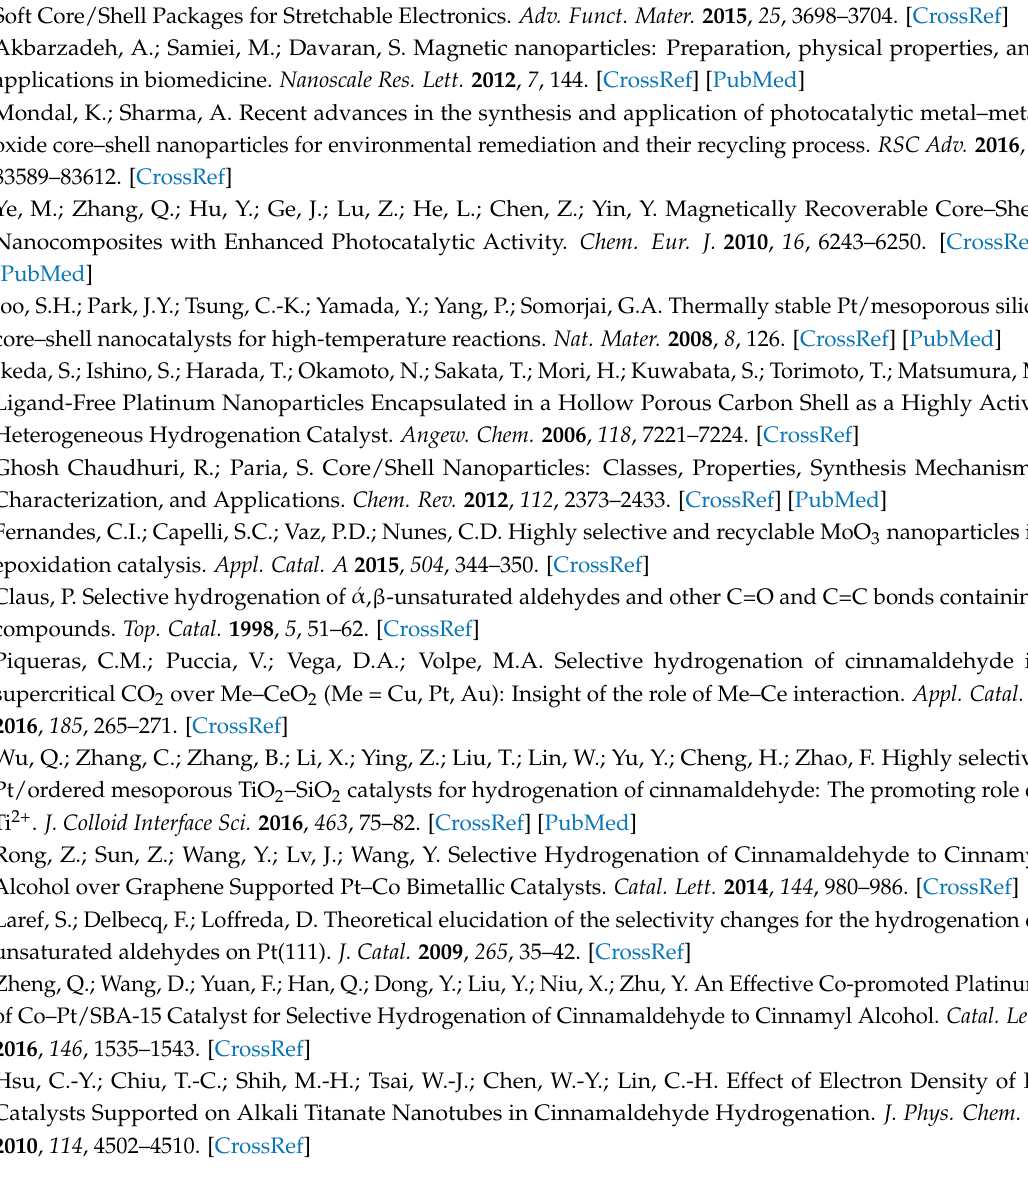
Figure S1: Micrograph of Fe 3 O 4 nanoparticles, Figure S2: Micrograph of Fe 3 O 4 –SiO 2 core-shell material, Figure S3: Micrograph of Fe 2 O 3 –SiO 2 –TiO 2 –5%Pt one-step core-shell material, Figure S4: N 2 adsorption desorption Isotherm, Figure S5: XRD pattern for Fe 3 O 4 and γ -Fe 2 O 3 nanoparticles, Figure S6: TPR-1 and TPR-2 of Fe 3 O 4 –SiO 2 –CeO 2